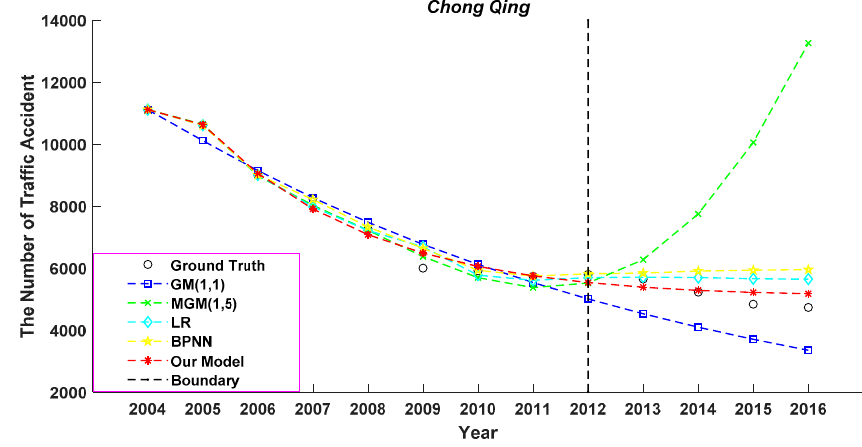
Figure 2. Result of trend prediction for Chong Qing city.